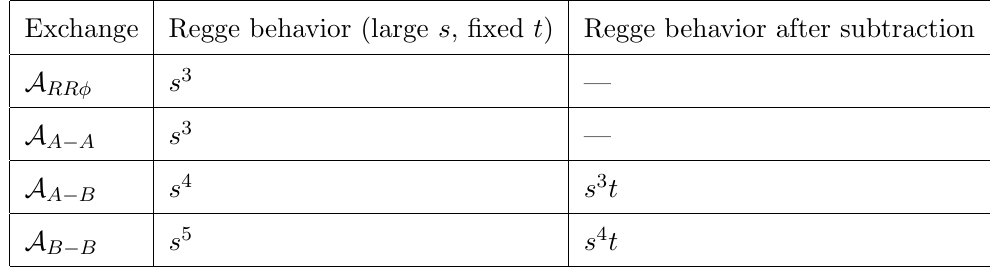
Table 9 . Regge behavior of exchange diagrams for massive